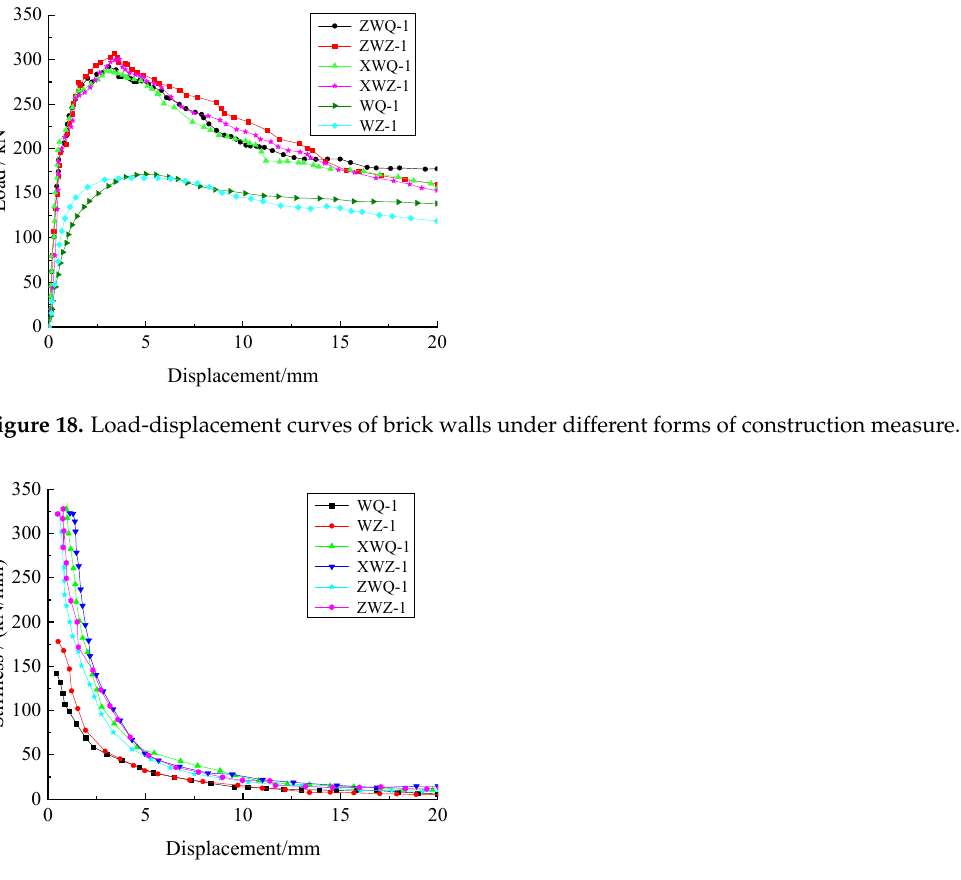
Figure 19. Stiffness-displacement curves of brick walls under different forms of construction measure.